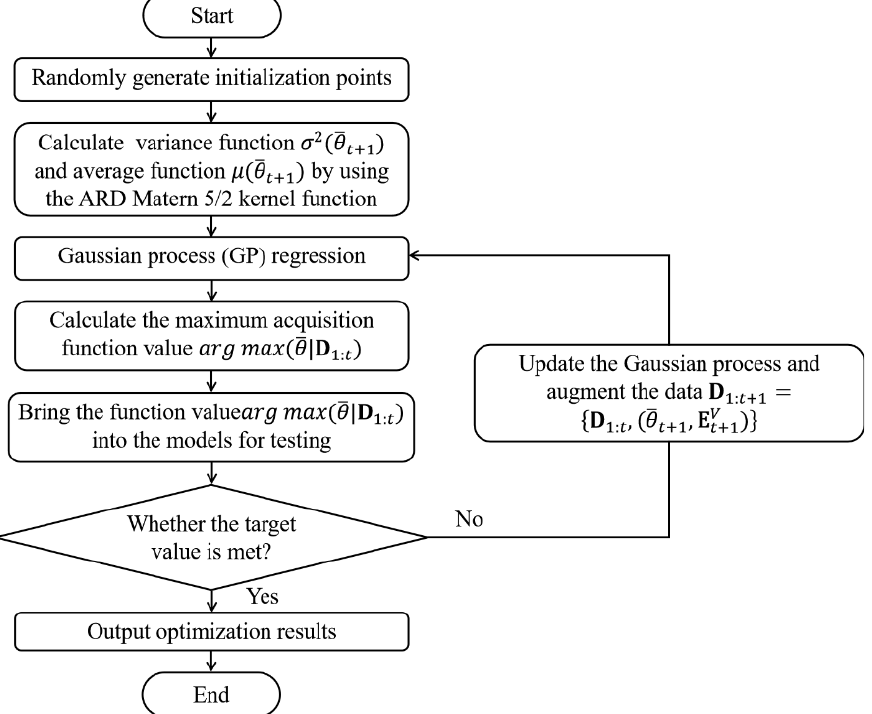
Figure 4. Flow chart for Bayesian optimization calculation.